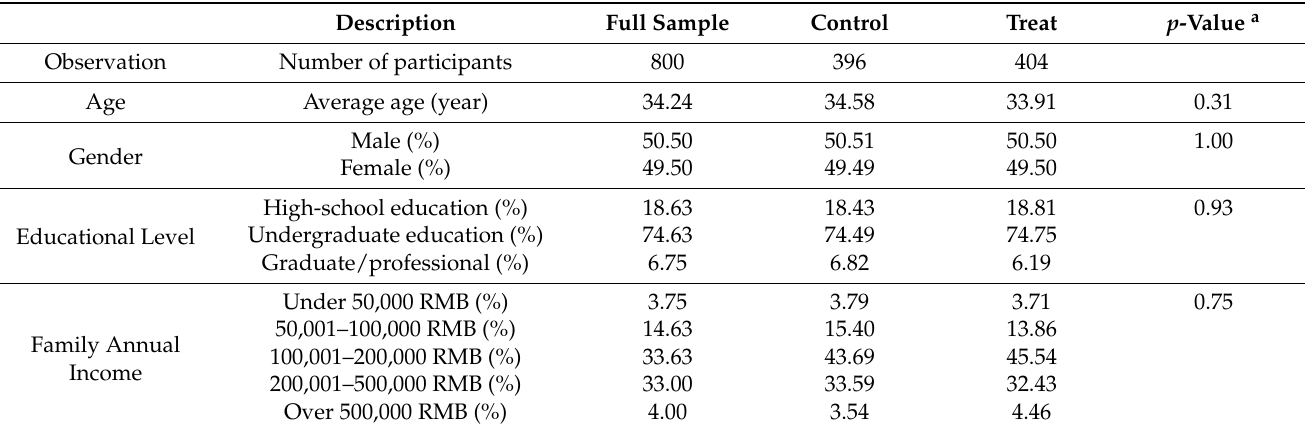
Table 2. Summary of sample